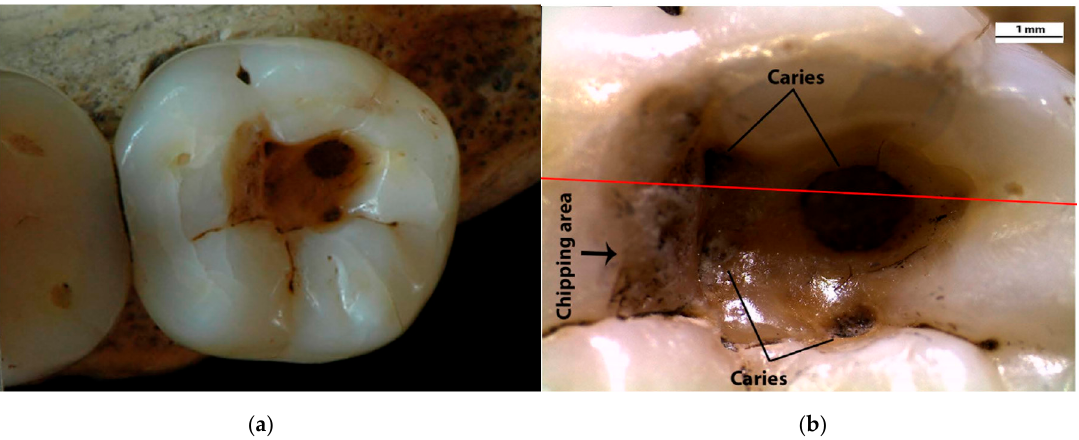
Figure 5. Top view the lower right third molar (RM3) of the man from Villabruna from the Late Upper Palaeolithic about 14,000 years ago; ( a ) Occlusal view; ( b ) detailed view of the occlusal cavity, with the four carious lesions and the chipping area on the mesial wall; red line is directed mesio-distally, passing through the larger carious lesion [109].